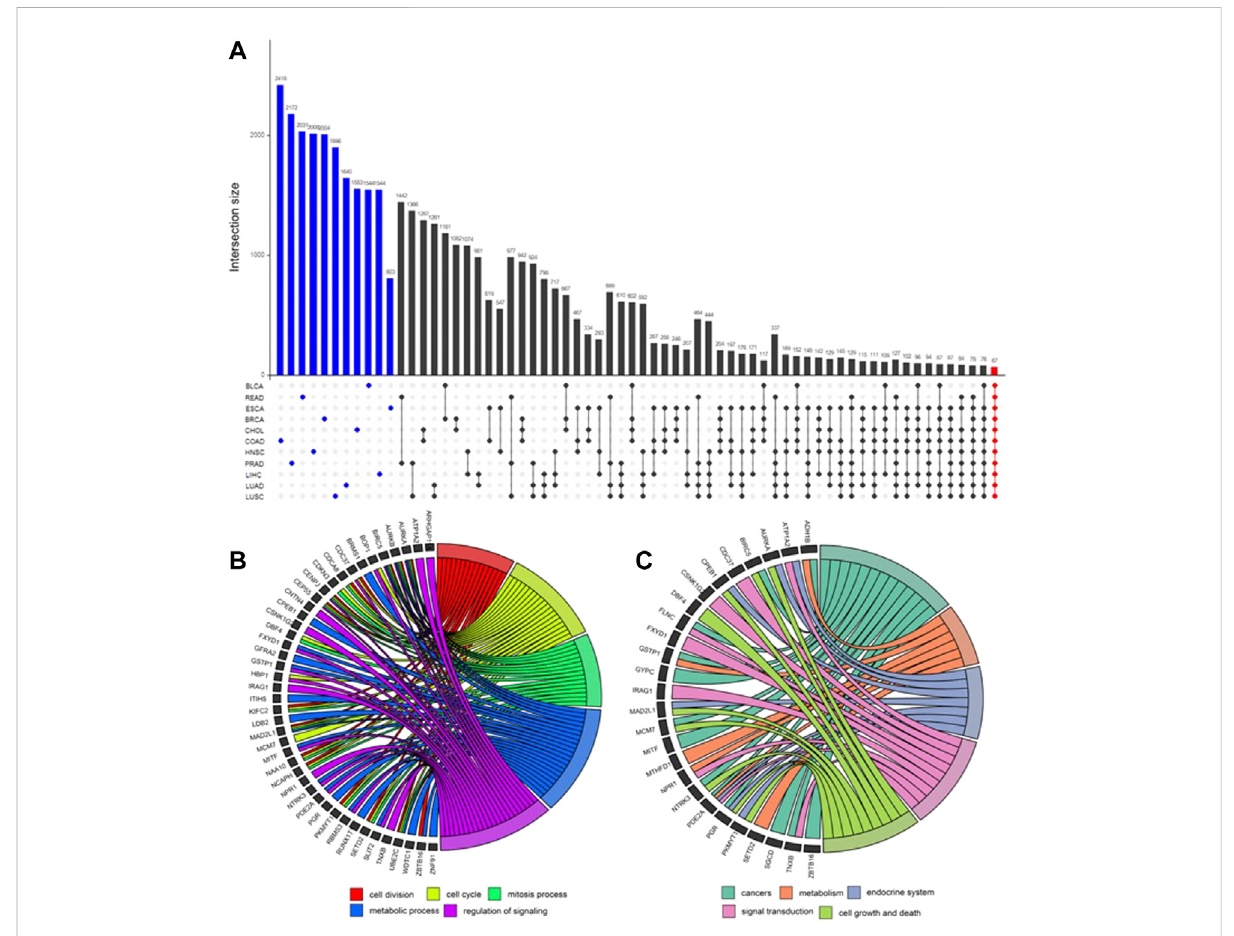
FIGURE 5 UpSet plot for differential genes ’ intersection among 11 cancers and functional enrichment analysis. (A) In the UpSet plot, the intersection of differentcancersisrepresentedbysoliddotsandlines,andthenumberofintersectionsisrepresented bythehistogram above.Differentnumbersof signi fi cantly differential genes for each cancer (marked blue) were identi fi ed. Finally, 67 early-stage pan-cancer biomarkers wereidenti fi ed by taking the intersection of 11 cancers (marked red). (B) Gene Ontology (GO) enrichment analysis. The top fi ve signi fi cantly enriched GO biological processes and relevant genes. (C) Kyoto Encyclopedia of Genes and Genomes (KEGG) pathway enrichment analysis. The top fi ve signi fi cantly enriched KEGG pathways and relevant